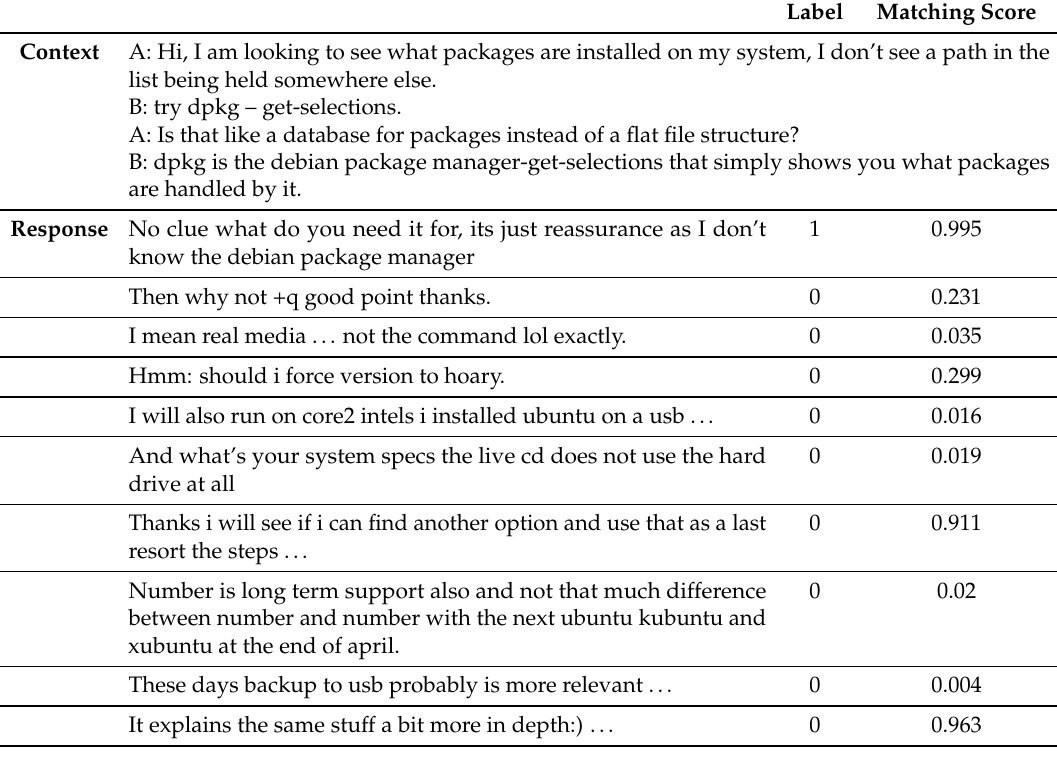
Table 1. Sample of Ubuntu Dialogue output with Matching Score of